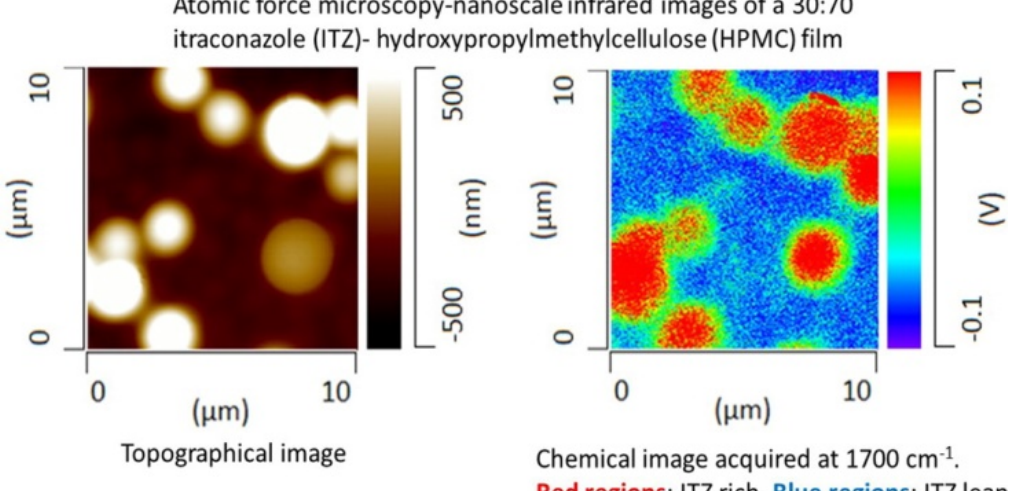
Figure 6. The miscibility of itraconazole ‐ hydroxypropyl methylcellulose blends (30:70) characterized by AFM ‐ IR. Re ‐ produced with permission from reference [66]. Copyright American Chemical Society, 2015.